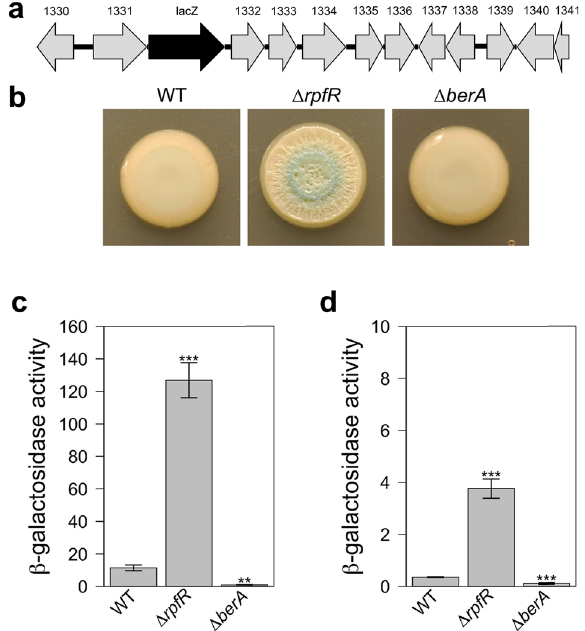
Fig. 3 Effect of RpfR on Bep expression. A lacZ reporter gene was introduced into the chromosome downstream of the BCAM1331 ( bepB ) gene by allelic exchange in the wild type, the rpfR mutant and the berA mutant. A Schematic presentation of the location of the lacZ reporter gene into the bep operon between bcam1331 and bcam1332 . B Macrocolony morphology and β -galactosidase expres- sion of the bepB :: lacZ reporter strains after growth for 6 days on NYG agar plates supplemented with X-gal. C, D Quanti fi cation of β -galactosidase activity (Miller units) of bepB :: lacZ reporter strains grown in AB medium supplemented with 1.5% glycerol ( C ) or NYG medium ( D ) for 24 h. Note that the scale is different in panels ( B ) and ( C ). The values shown are the means ± SEM of 2 independent experiments. The signi fi cance levels, as determined using a one-way ANOVA, of the difference between the strains are indicated above the bars; *** P < 0.001; ** P <